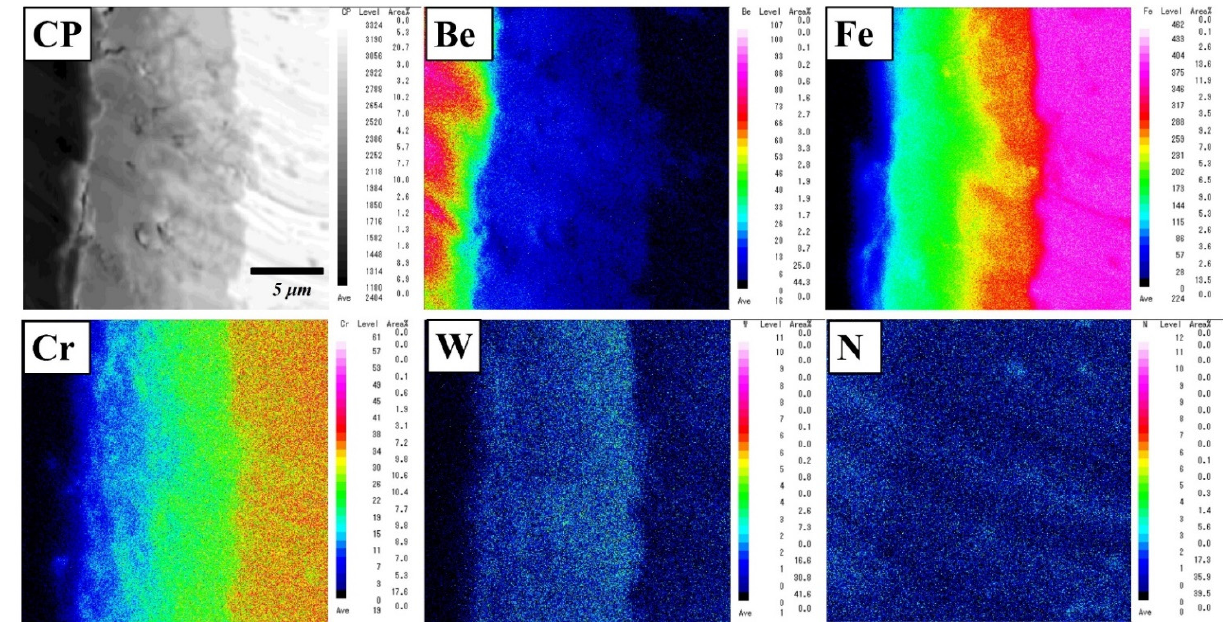
Figure 4. Elemental mapping of a reaction layer in a Be–F82H joint sintered at 1023 K for 90 min.